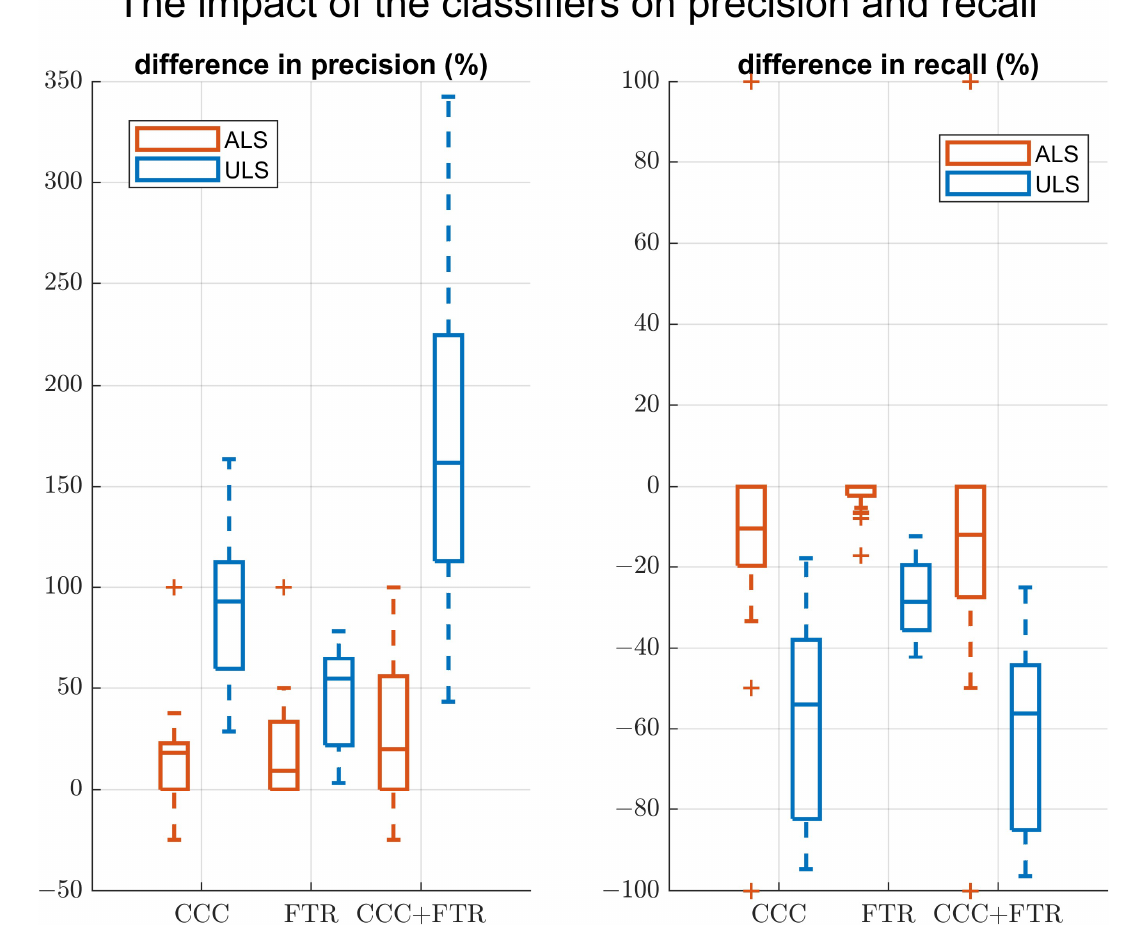
Figure 6. Boxplots of the proportional differences in precision and recall for the ALS and ULS datasets between the base case (no filters used) and cases when filters were used. CCC denotes that the connected component classifier was used, FTR denotes that the false tree remover was used and CCC+FTR denotes that both of the filters were used. For example, the leftmost boxplot on the left subplot shows that, on average, using the connected component classifier improved precisions of ALS data by approximately 18% compared to the case when no filters were used.